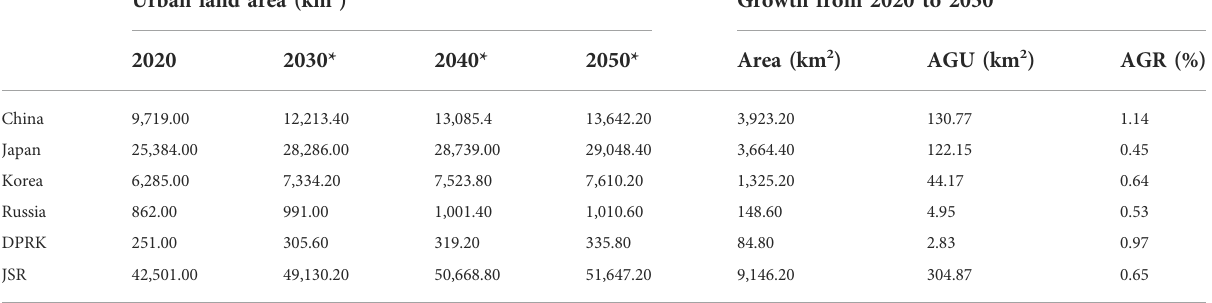
TABLE 1 Urban land growth in the JSR from 2020 to 2050 under the SSPs. Urban land area (km 2